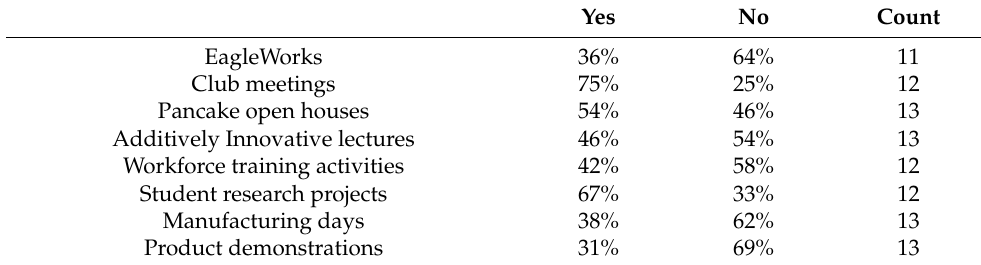
Table 2. Distribution of respondents by their participation in iMakerSpace events.